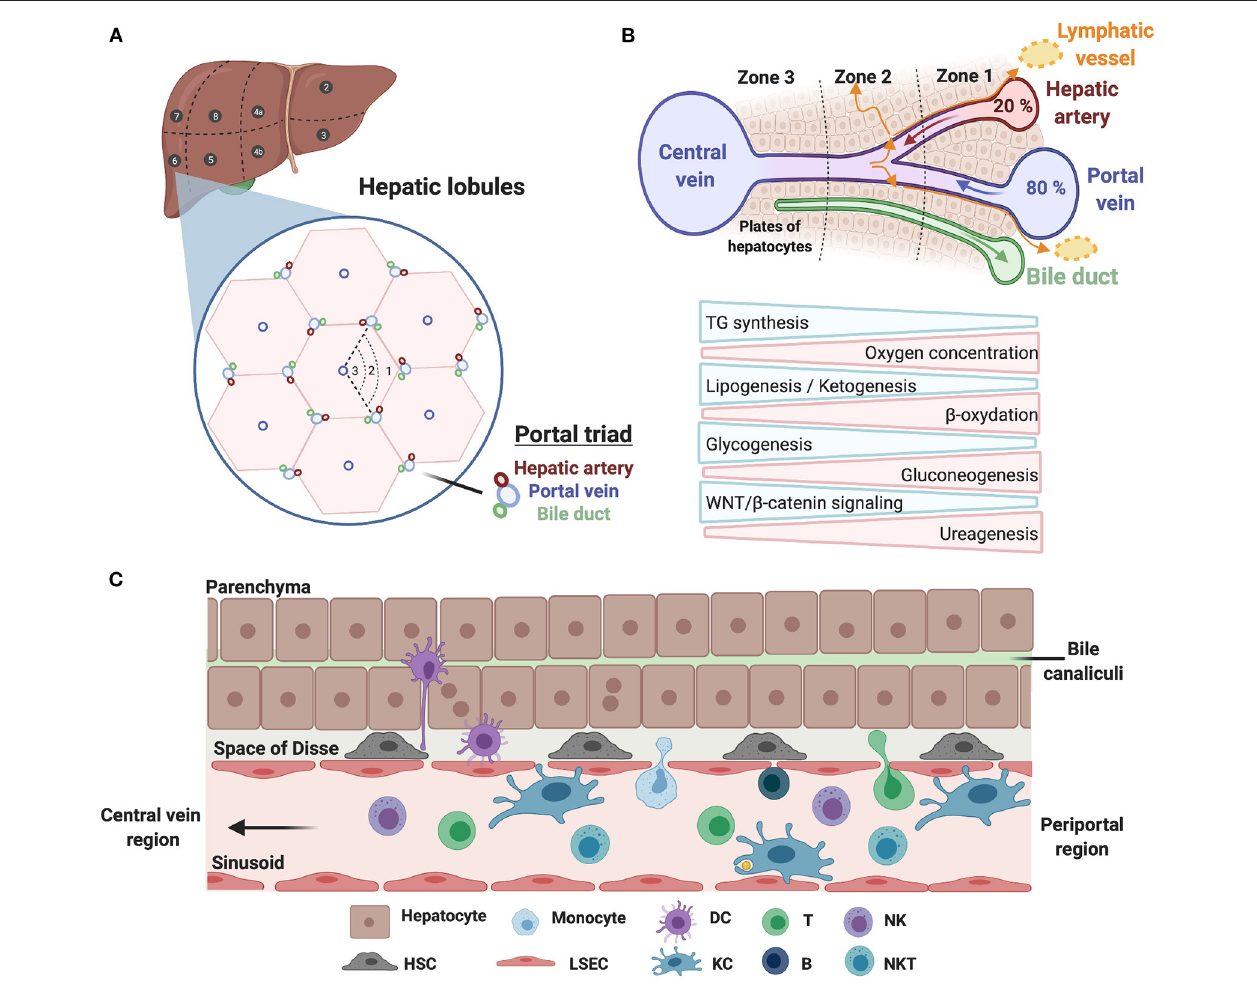
FIGURE 2 | Architecture of the human liver and its immune system. (A) Schematic illustration of the human liver anatomy namely its 8 segments, hepatic lobules, and triads of portal vein/hepatic artery/bile duct. (B) The liver zonation. Oxygen and metabolic gradients define three liver zones with specialized hepatocytes functions. (C) A zoom on hepatic cellular interactions across the sinusoids, the space of Disse and the hepatocyte plates. Liver sinusoidal endothelial cells (LSECs) line the liver sinusoid by forming a fenestrated monolayer. Their basal side interacts with hepatocytes and hepatic stellate cells (HSCs) in the space of Disse, whereas their luminal side interacts with liver-resident leukocytes, including Kupffer cells